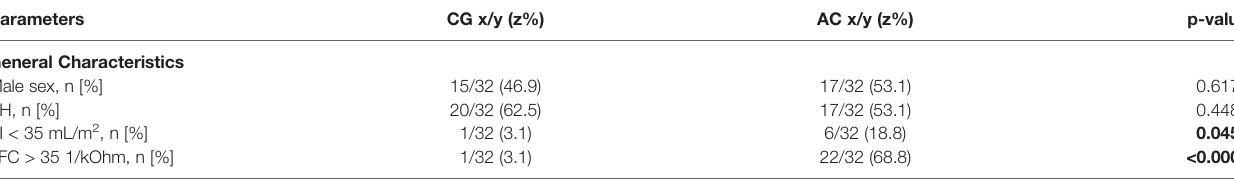
TABLE 5 | Comparison of the control group (CG) and the acromegaly (AC) group in terms of selected parameters. .